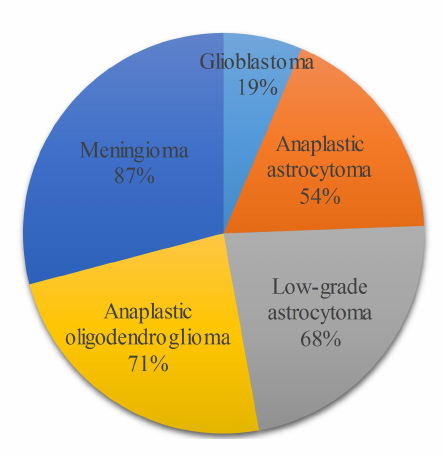
Figure 1. The 5 tumor types with their survival rates for patients aged between